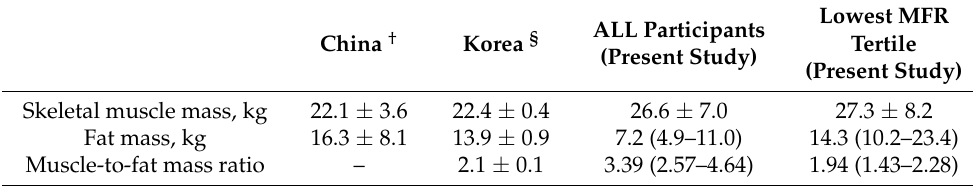
Table 3. Appendicular skeletal muscle mass, fat mass, and muscle-to-fat mass ratio in general boys in China [26] and Korea